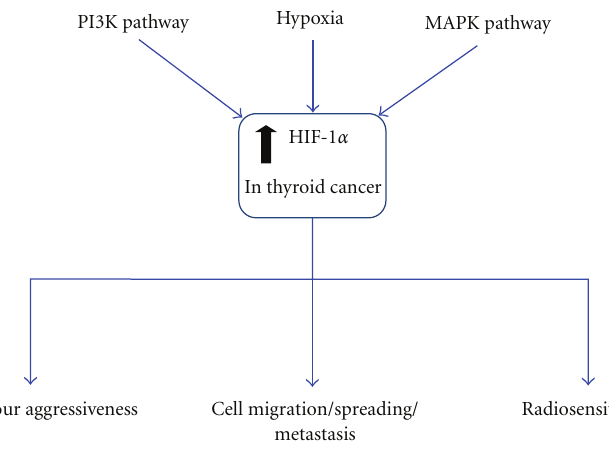
Figure 6: Mechanisms of induction of HIF-1 α and downstream e ff ects of HIF-1 signalling in thyroid carcinomas. HIF-1 activity is induced not only by hypoxia but by the oncogenic MAPK and PI3K signalling pathways. Clinically, expression of HIF-1 α and the downstream target CA-9 have been linked with thyroid carcinoma aggressiveness. It is well known that HIF-1 plays an important role in tumour development, metastasis, and aggressiveness and is ultimately correlated with poor prognosis. Enhanced HIF-1 signalling by hypoxia and the PI3K/MAPK pathways may play an important role in the metastatic characteristics of thyroid carcinoma. HIF-1-induced MET upregulation has been implicated in promoting invasiveness of PTC. HIF-1 signalling may also play a prominent role in the therapeutic response to radiotherapy in thyroid